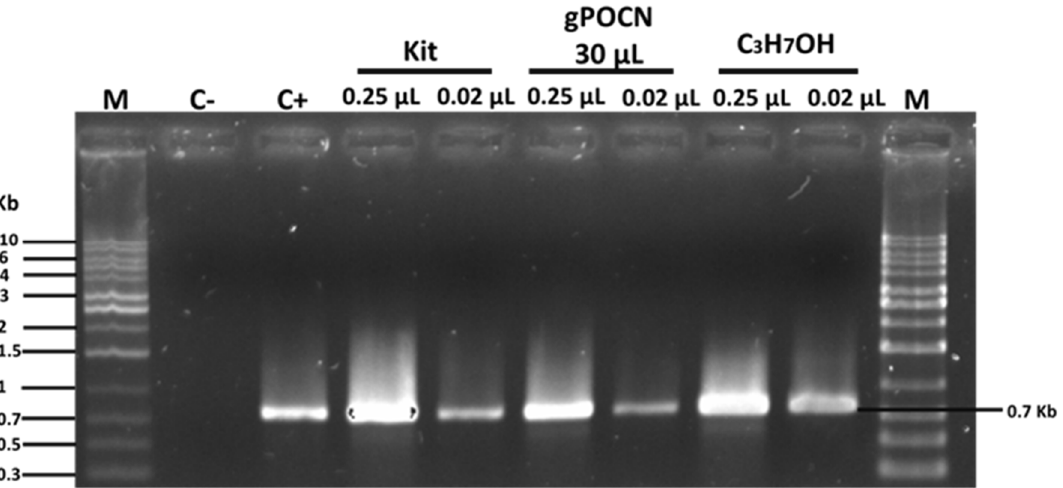
Figure 10. Analysis of PCR products amplified with ITS primers using different genomic DNA extraction methods. Lane 1 and 10, molecular weight markers; lane 2, negative control; lane 3, positive control; lanes 4 and 5, DNA extracted by a commercial kit using different concentrations; lanes 6 and 7, DNA extracted by g-POCN using different concentrations; lanes 8 and 9, DNA extracted by isopropanol using different concentrations.